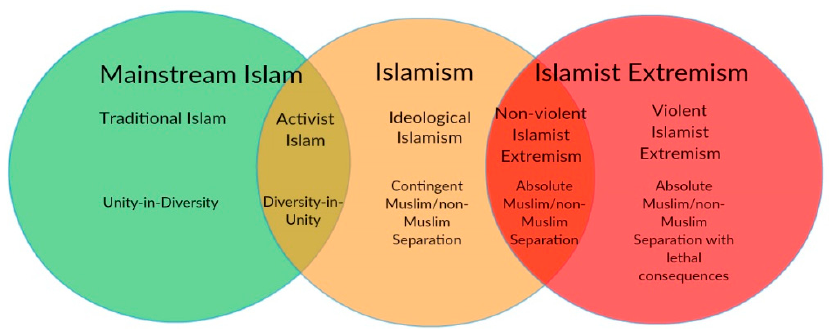
Figure 1. The Worldviews of Mainstream Islam, Islamism and Islamist Extremism.